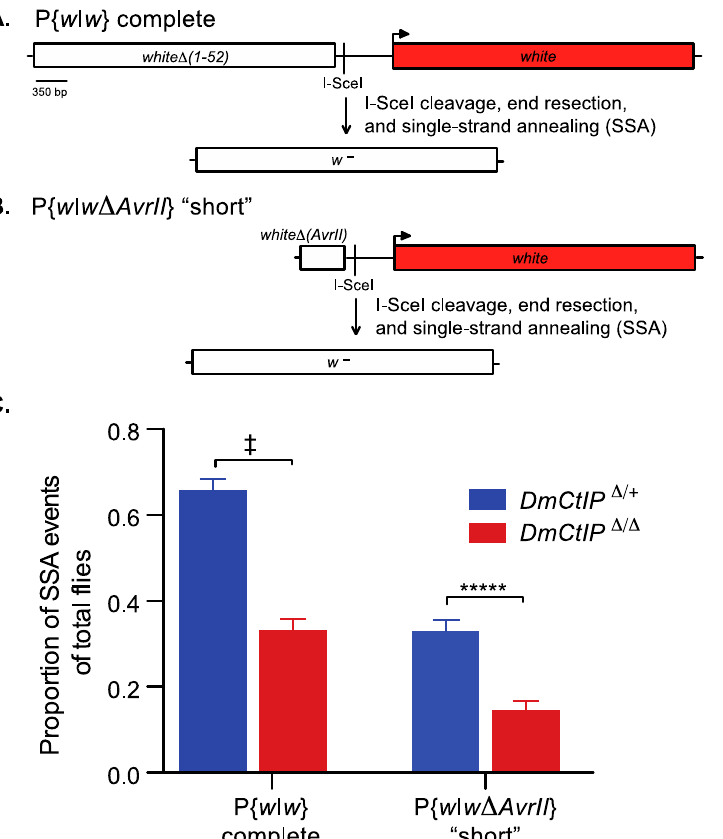
Figure 2. DmCtIP ∆ / ∆ mutants are deficient in SSA repair in both short and long end-resection. The P{ w I w } SSA assays contain an I-SceI recognition sequence inserted between a non-functional (white box) and a functional (red box) copy of the white gene (full-length gene sequence except for 5 (cid:48) UTR). ( A ) The complete P{ w I w } SSA assay contains a non-functional white gene ( white ∆ (1–52); white box) due to deletions of the first 52 bp, including the ATG start codon. Following I-SceI cleavage, end resection of ~3.6 kb and single-strand annealing, a single non-functional copy of white results ( w − ) due to loss of the ATG site. ( B ) The “short” P{ w I w ∆ AvrII } SSA assay contains a non-functional white gene ( white ∆ (AvrII); white box) due to deletions of the first 52 bp (including ATG) and the last 3.0 kb (3 (cid:48) end and 3 (cid:48) UTR). Following I-SceI cleavage, end resection of ~550 bp and single-strand annealing, a single non-functional copy of white results ( w − ) due to loss of the ATG site. ( C ) Embryos containing the respective P{ w I w } constructs and a heat-shock inducible I-SceI transgene are heat shocked, creating a site-specific DSB, and males are crossed to y w tester females to score individual premeiotic germline repair events. I-SceI-induced DSB repair events from the complete P{ w I w } assay in a DmCtIP ∆ / ∆ mutant background (red; n = 23 germlines, 1708 total flies scored) compared to DmCtIP ∆ /+ heterozygote controls (blue; n = 25 germlines, 1852 total flies scored). DSB repair events from the P{ w I w ∆ AvrII } assay in a DmCtIP ∆ / ∆ mutant background (red; n = 22 germlines, 1361 total flies scored) compared to DmCtIP ∆ /+ heterozygote controls (blue; n = 26 germlines, 1957 total flies scored). Results shown are averages ± S.E.M. of individual male germline events. ‡ p < 10 − 10 ; ***** p < 0.00001 by unpaired Student’s t